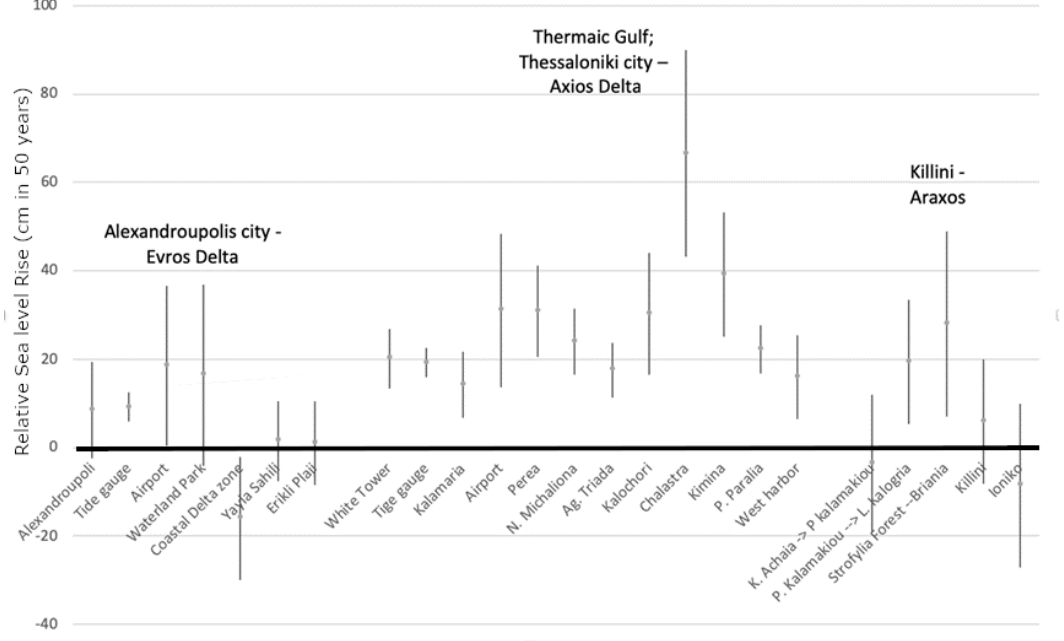
Figure 7. Indicative diagram of relative sea level rise (with uncertainties) of the sub-areas within the three case studies mapped in Figures 3, 5 and